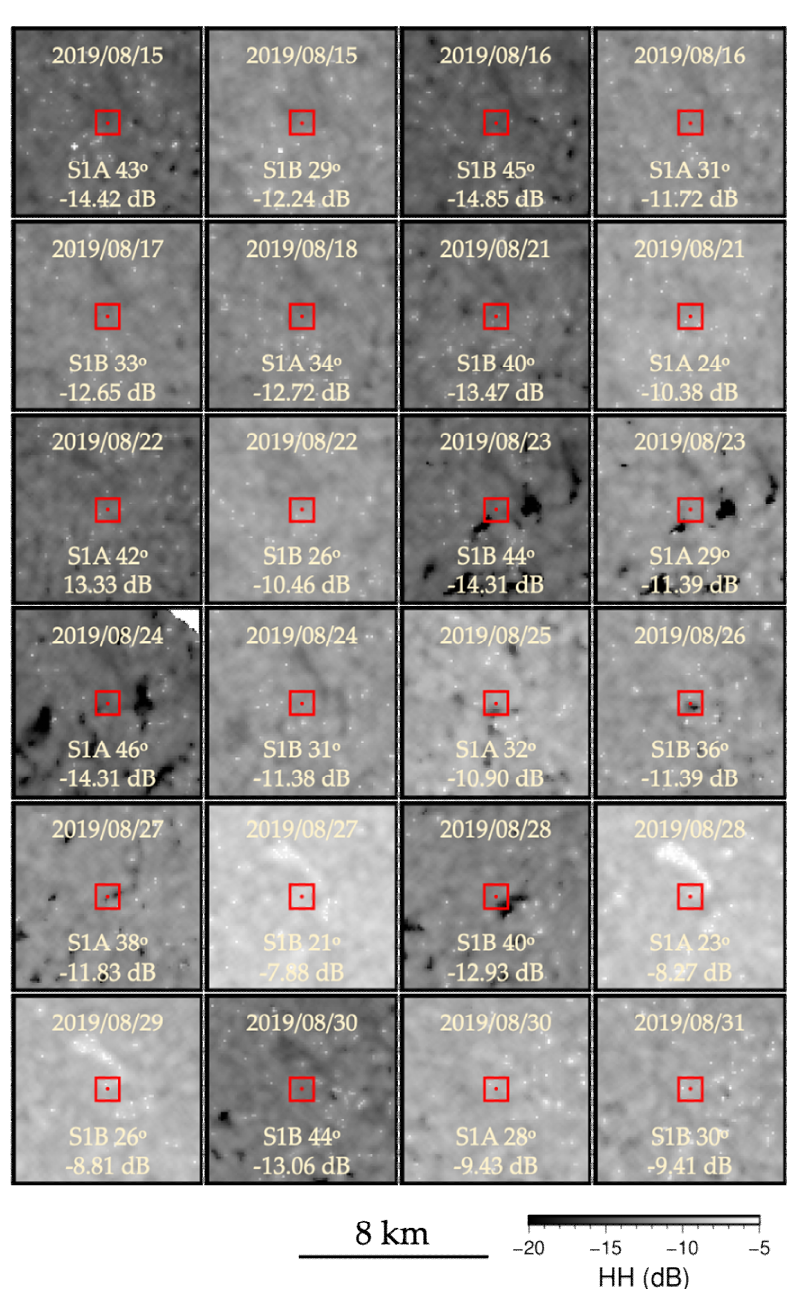
Figure 3. Time-series of radiometrically calibrated Sentinel-1A / B images in HH-polarization, along with the acquisition date and incidence angle. A red square indicates a sample window of 1 × 1 km which backscatter statistics were